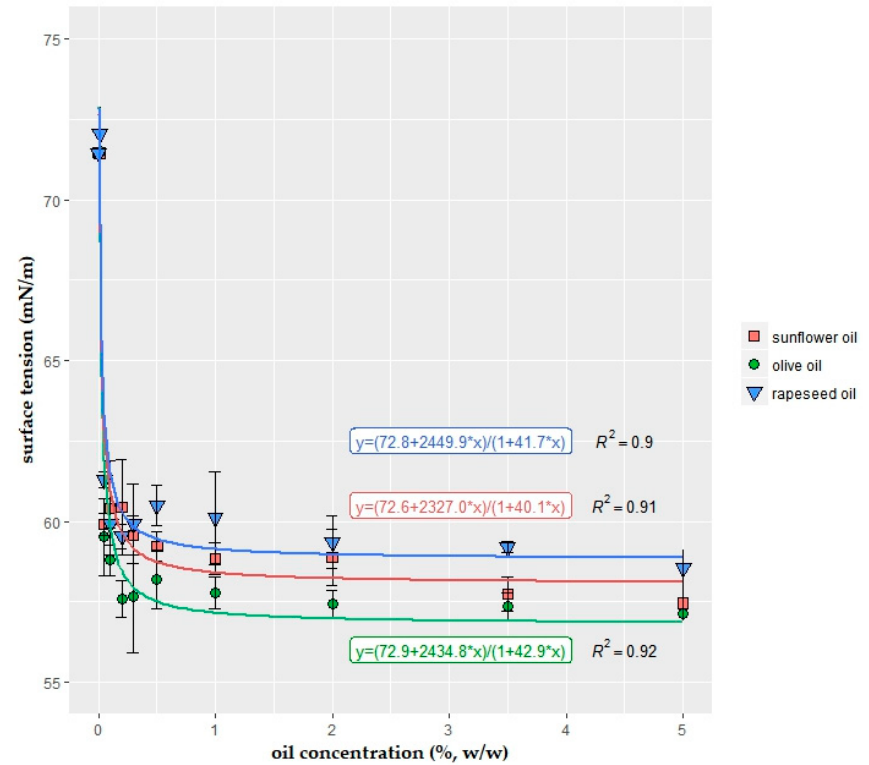
Figure 3. Variation of the surface tension (mN/m) of the solution with the concentration (%, w / w ) of vegetable oils: sunflower, olive, and rapeseed oil. Each concentration was added into 1.25% sodium alginate + 2% glycerol solutions ( n = 3 replications).